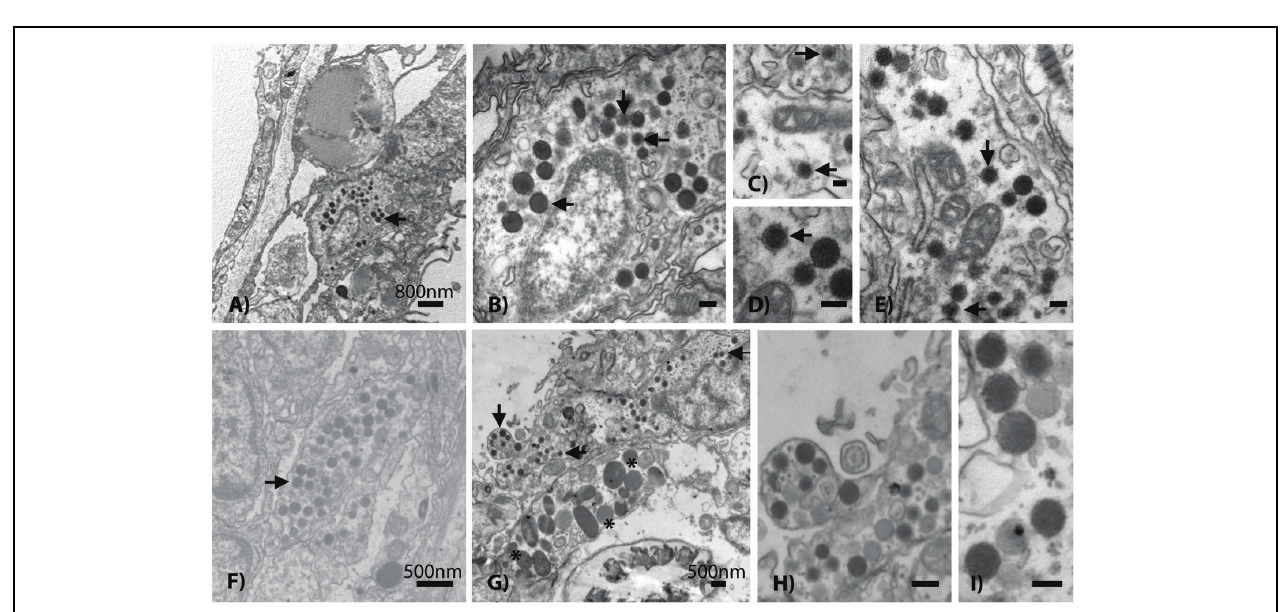
FIGURE 3 | Relative percentage of viral Families found in a single control Acropora aspera coral virome (generated from five coral fragments) using the best tBLASTx similarities to assembled contigs. Bar heights indicate the relative percentages of best similarities to viral Families (eukaryotic viruses) or categories of phages. Colors of bars distinguish phages (dark blue and green) from eukaryotic viruses, and genome type within the eukaryotic viruses (red = dsDNA, purple = ssDNA, light blue = RNA).